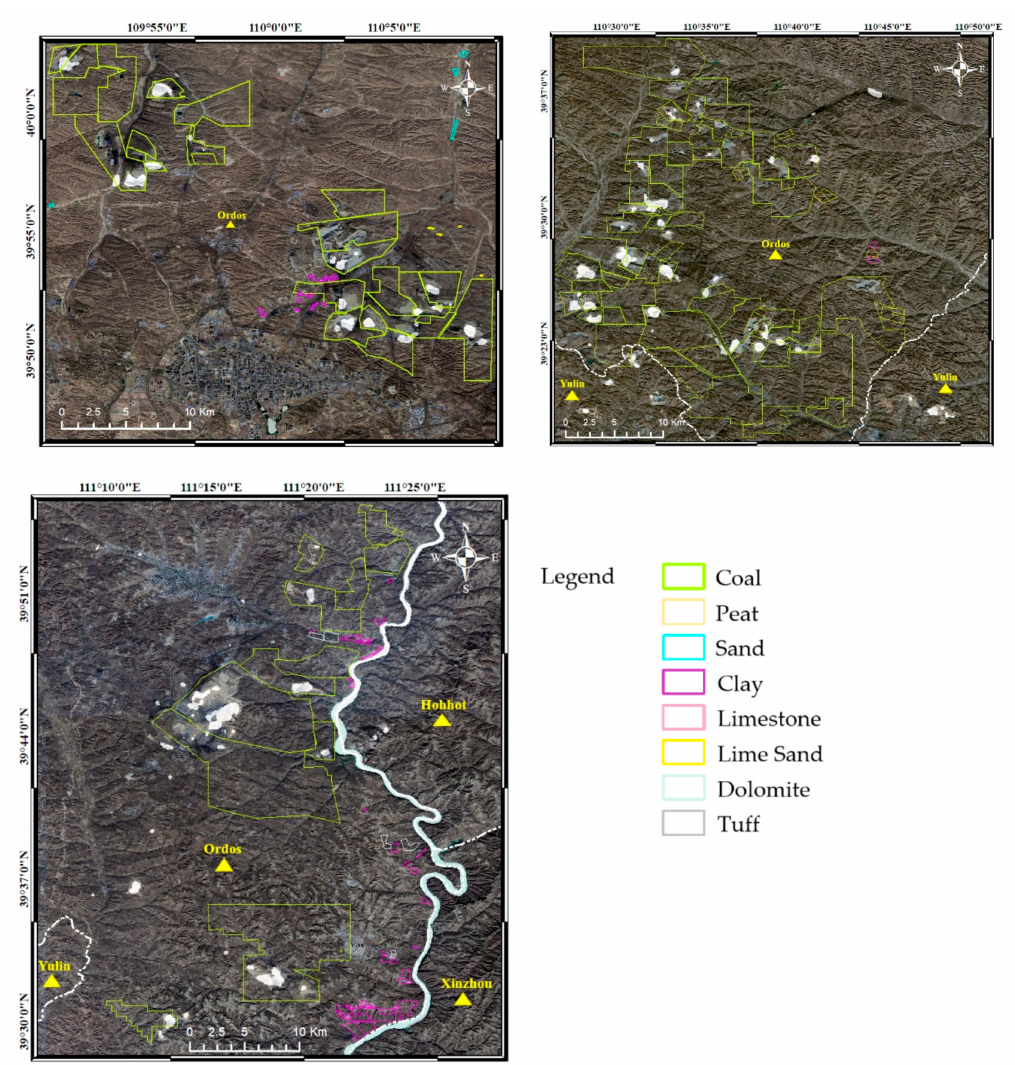
Figure 4. Overlay maps of decorrelation, mining rights, and optical